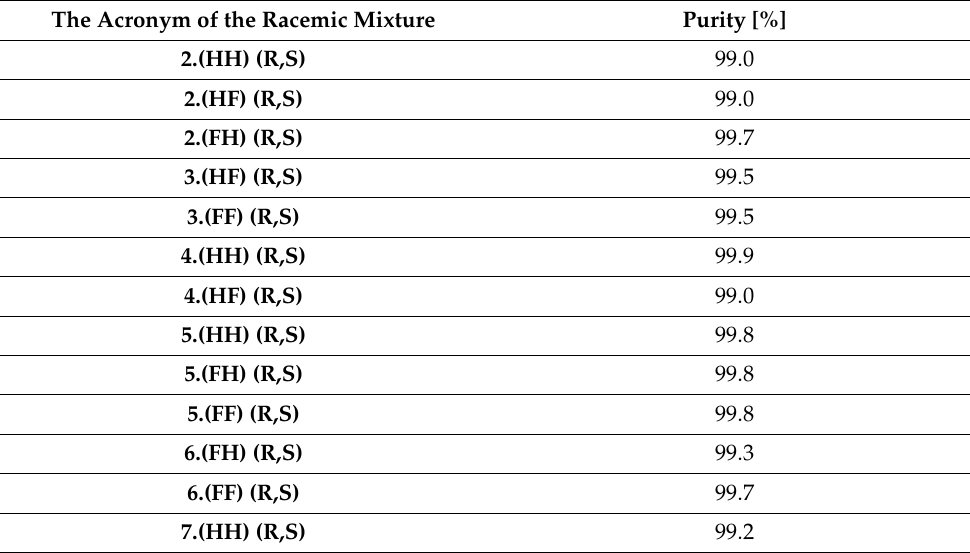
Table 1. The purity of the synthesized racemic mixtures. The Acronym of the Racemic